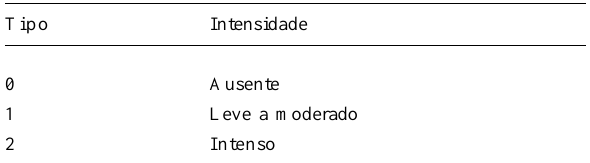
Tabela 3. Classificação do infiltrado